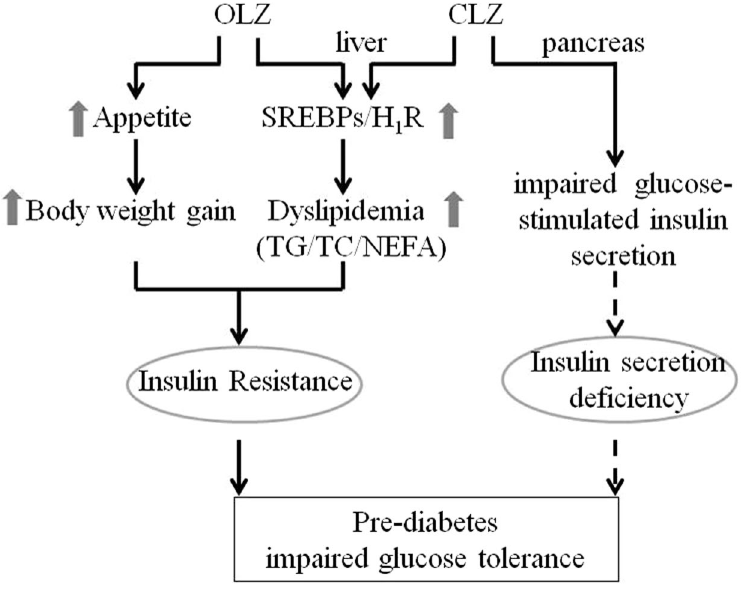
Figure 7. A schematic diagram of the proposed pathways for OLZ- and CLZ-induced glucose-lipid metabolic